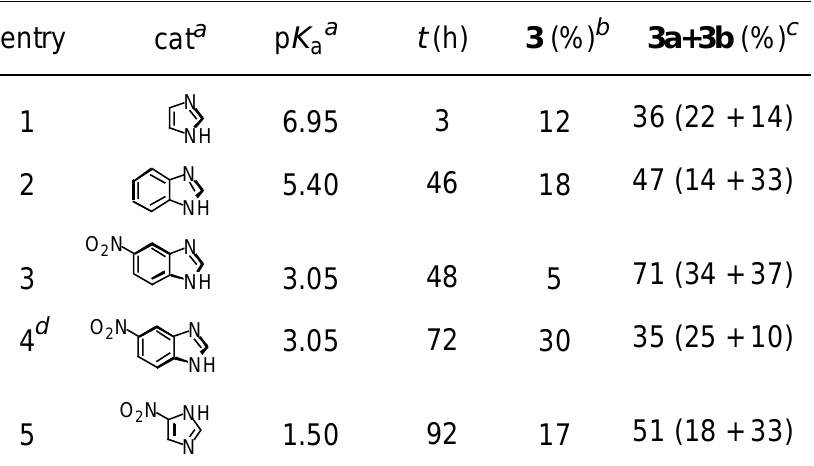
Table 2. Claisen self-condensation of thiomalonate 3 in THF d at room temperature in presence of Mg(OAc) imidazole